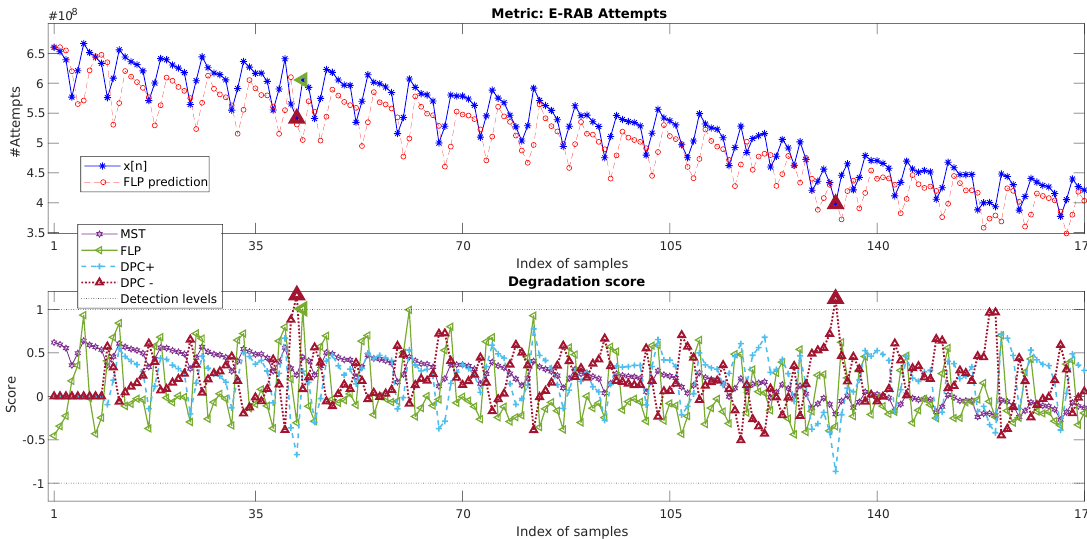
Figure 15. Two-day data of the daily metric E-RAB attempts, its prediction using the baseline linear filter ( top ), and its absolute prediction error ( bottom